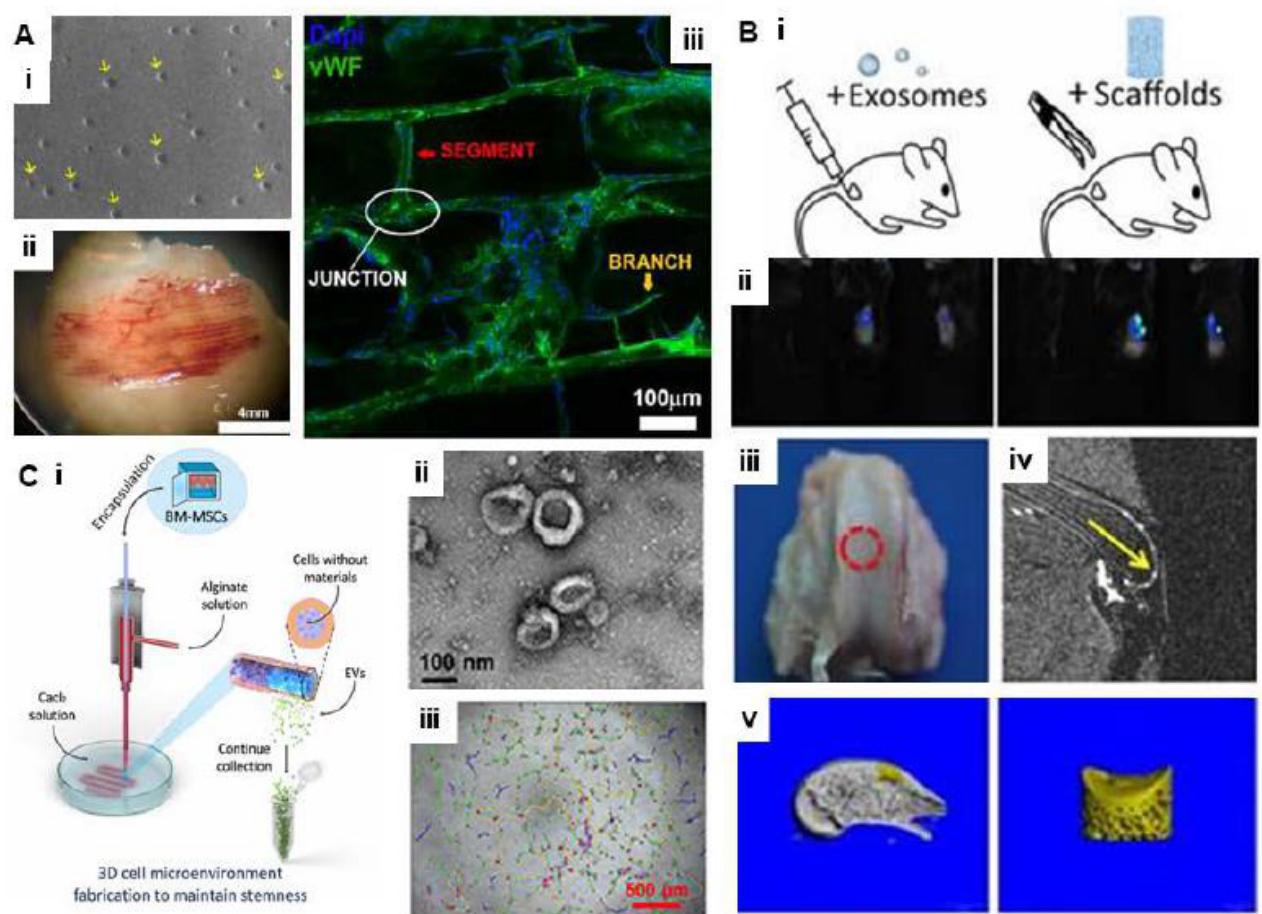
Figure 8. ( A ) Three-dimensional-bioprinted endothelial-derived extracellular vesicles. (i) SEM images of 3D-bioprinted hydrogels (GelMA with EVs). Yellow arrows show vesicles; (ii) representative images of serum-free M200 medium in hypoxia (SM Hypoxia) EV sample explanted neovascular networks after EDTA decalcification treatment; (iii) immunofluorescence image of vWF-positive vessels showing branching and angiogenesis (adapted and reproduced from [152]). ( B ) Three-dimensional-printed extracellular matrix/mesenchymal stem cell sEV scaffold for osteochondral defect repair. (i) In vivo fluorescence imaging of sEVs in PBS and in the 3D-printed scaffold. Both groups of sEVs were labeled with Vybrant DiO (green) dye before implantation; (ii) macroscopic evaluation of the osteochondral defect regions at 12 weeks; (iii) MRI imaging of repaired knees at 12 weeks after surgery (yellow arrow indicates the repaired sites); (iv and v) µ CT reconstruction imaging of repaired knees at 12 weeks after surgery (adapted and reproduced from [153]). ( C ) Three-dimensional coaxial bioprinting for EV production. (i) Scalable production of highly enriched EVs using 3D cell fiber culture. MSCs and alginate solution were extruded through the inner and outer streams of the coaxial printer head, respectively, to form a dense 3D cell fiber that promotes cell survival and stemness maintenance; (ii) TEM of EVs isolated from 3D cell fiber culture showing a typical ‘cup-shaped’ morphology; (iii) evaluation of endothelial cell tube formation with EVs using a Matrigel matrix. Morphology of the endothelial network stimulated with 3D (2.8 × 109 particles mL − 1 ) EVs (adapted and reproduced from